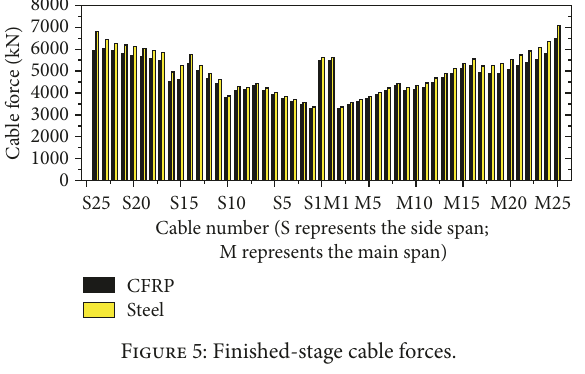
Figure 5: Finished-stage cable